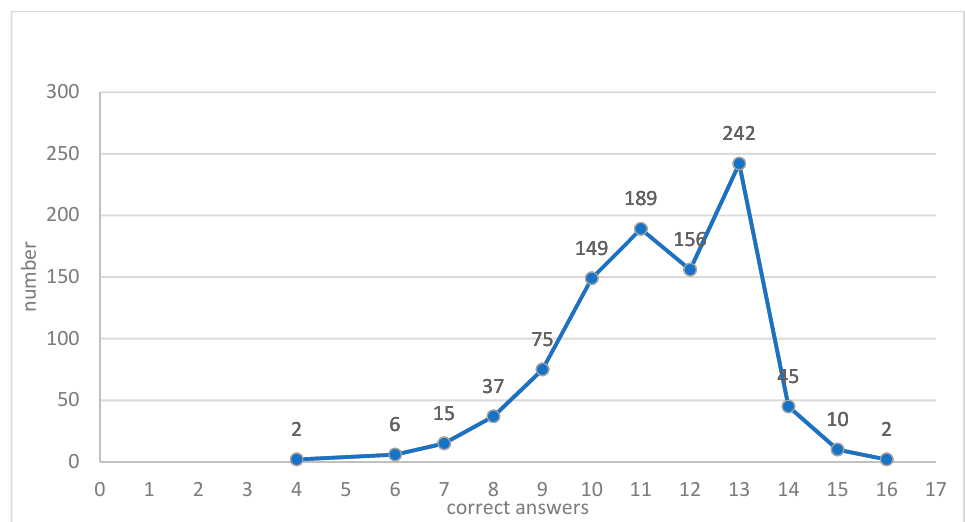
Figure 1. Frequencies of correct answers in the Advance Directives Knowledge Scale (ADKS). Table 2. Sample distribution for each ADKS